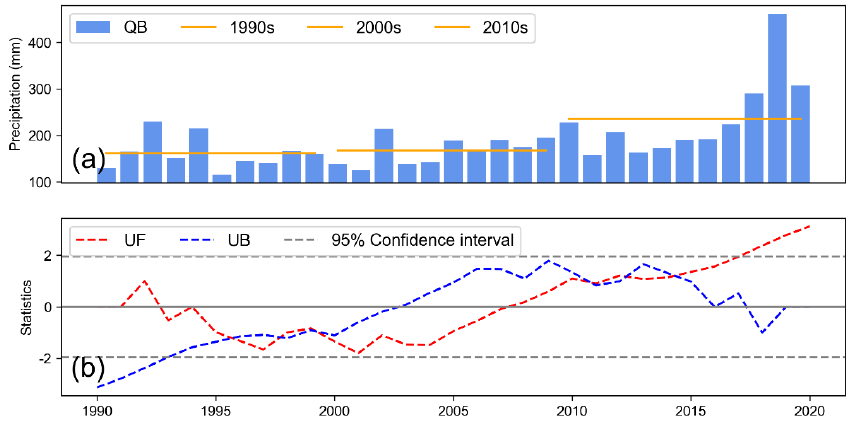
Figure 6. ( a ) Change of precipitation in the Qaidam Basin from 1990 to 2020. The orange solid line represents the decade average of the change in Precipitation. ( b ) Mann-Kendall test results of precipitation.